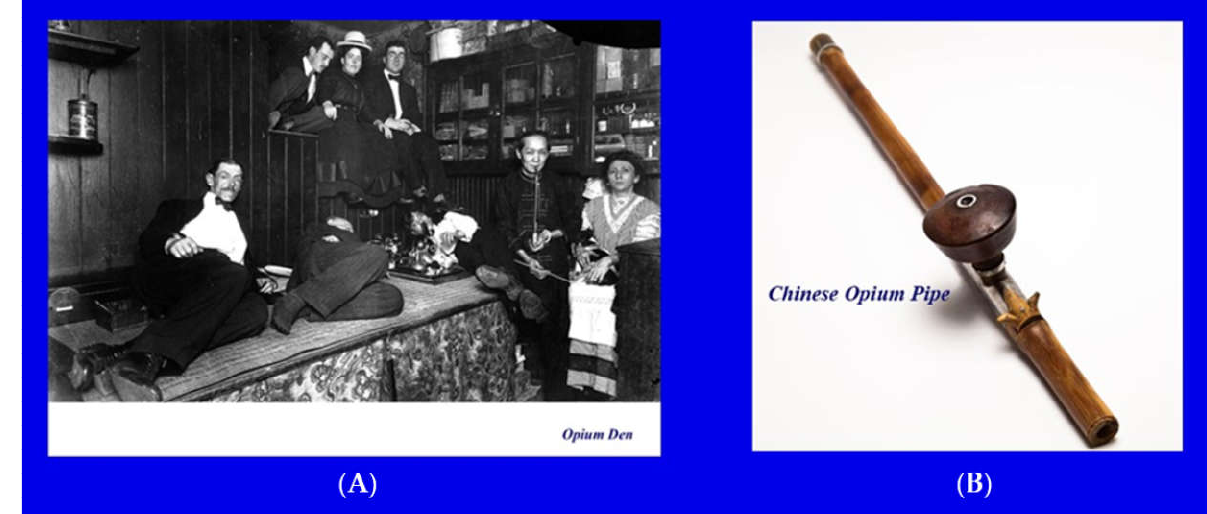
Figure 4. Opium den and pipe. ( A ) Opium den and ( B ) pipe. Photographs are public